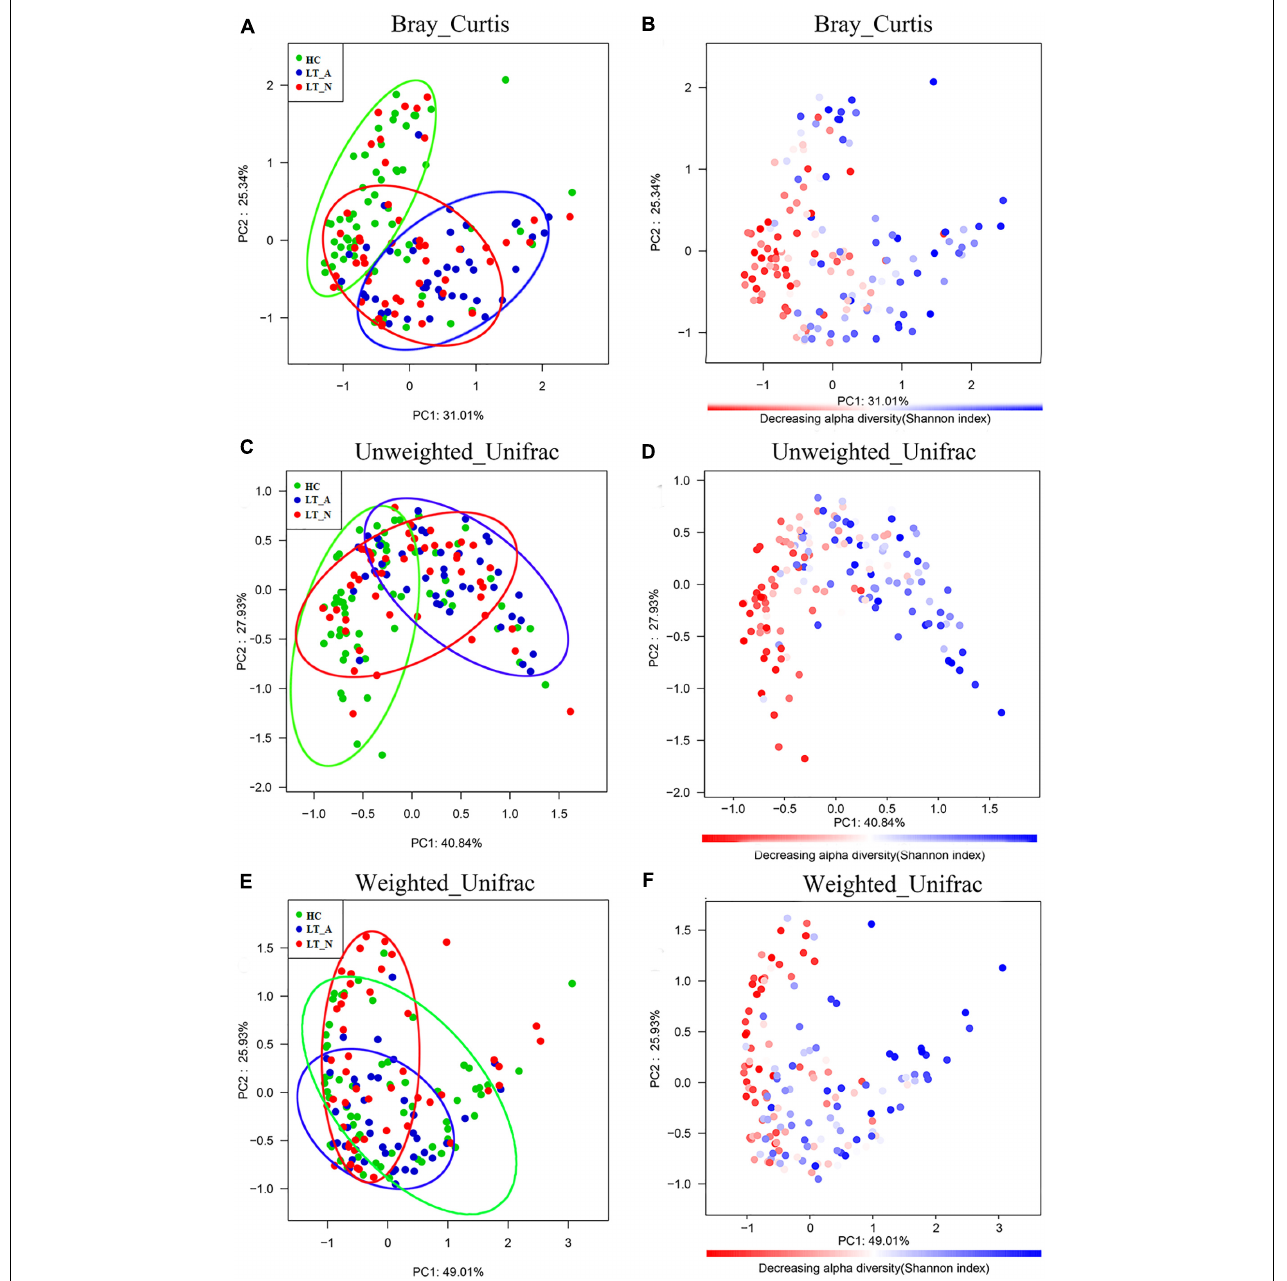
FIGURE 2 | Bacterial diversity clustering determined by combining the results of Bray-Curtis analysis and unweighted and weighted UniFrac PCoA of fecal microbiota. The beta diversity is different between LT_A and HC, and LT_A and LT_N ( P < 0.05 using PERMANOVA analyses with R-vegan function Adonis). The variance explained by the principal components is indicated in parentheses on the axis, and the ellipses highlight the clustering of the fecal microbiomes according to groups (green, Group HC; blue, Group LT_A; red, Group LT_N). (A,B) Indicate the results of Bray-Curtis analysis, (C,D) are the results based on unweighted UniFrac (qualitative) analysis, and (E,F) show the results of weighted UniFrac (qualitative) analysis. Each point represents a sample. (A,C,E) The samples from Group LT_A, Group LT_N, and Group HC are represented in blue, red, and green, respectively. (B,D,F) Microbial diversity maps. A highly diverse core (colored in red) indicates the bacterial diversity of Group HC is highest among the three groups (the color scale of red to blue reflects the decreasing alpha diversity of the fecal microbiome). LT_A, fecal microbiomes of the liver recipients with abnormal liver function; LT_N, fecal microbiomes of the liver recipients with normal liver function; HC, fecal microbiomes of the healthy control group; PCoA, principal coordinates